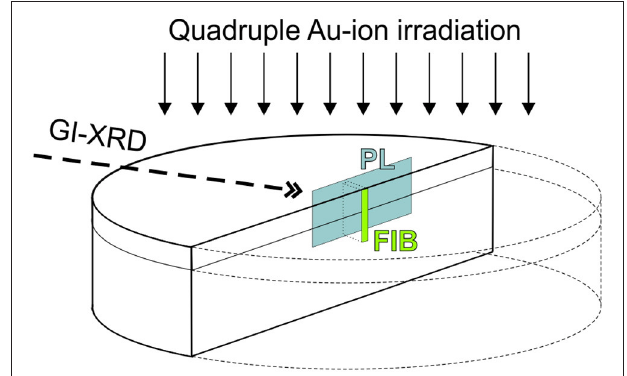
FIGURE 1 | Simplified sketch (not to scale) that summarizes preparation and techniques as applied to orthophosphate ceramics in this study: (1) Polished ceramic pellets were irradiated with Au-ions sequentially with four different energies (see details in Figure 2 and discussion in the text); (2) grazing-incidence X-ray diffraction (GI-XRD) was applied to characterize ion-irradiation induced damage in the uppermost surface layer. (3) Pellets were embedded in epoxy and prepared to cross-sectional mounts; (4) confocal laser-induced Photoluminescence (PL) spectroscopy and hyperspectral mapping; and (5) focused ion-beam preparation of TEM